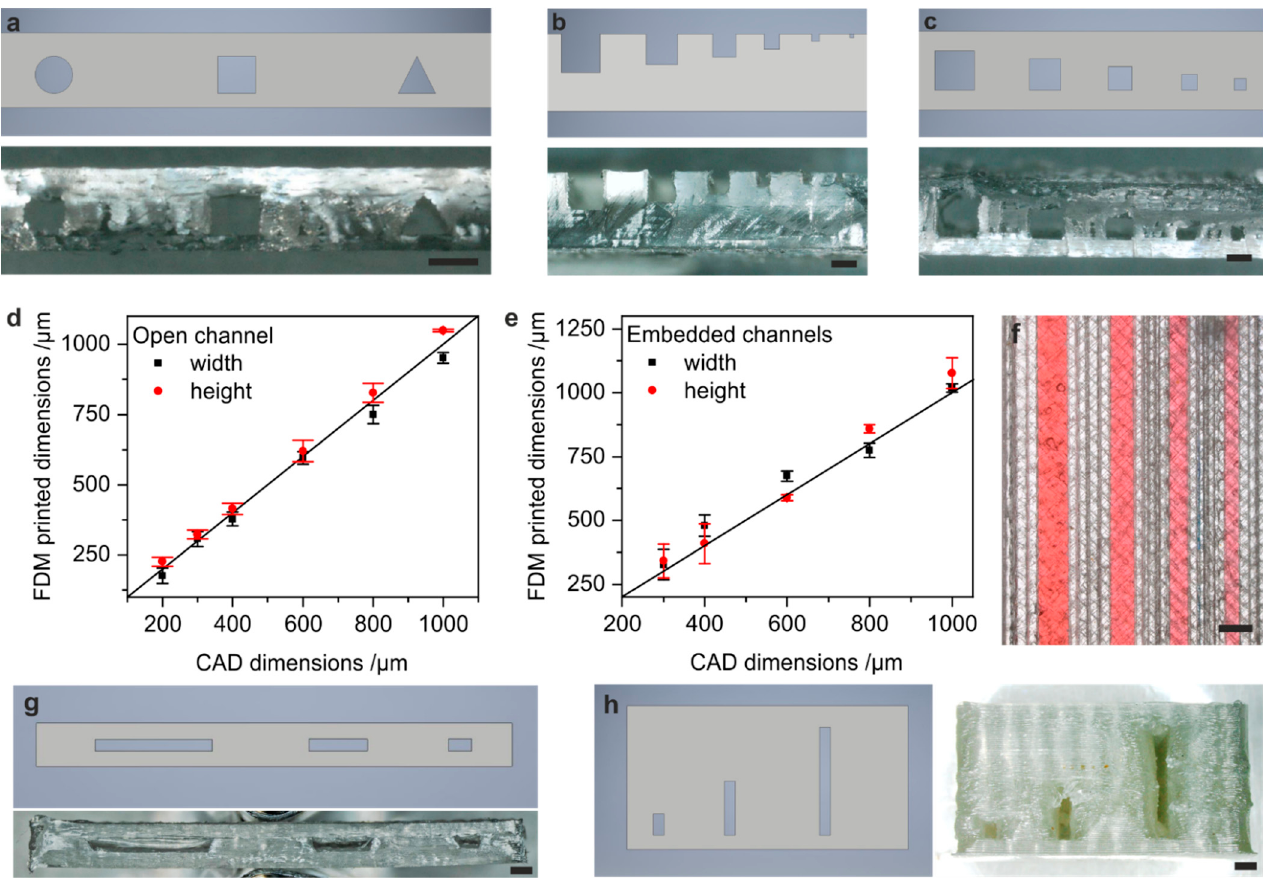
Figure 2. Accuracy and resolution of FDM-printed microfluidic channels in PS. ( a ) Cross-section of CAD model and FDM-printed PS, respectively, showing the possibility to print spherical, square and triangular channel cross-section with 600 µm features in high quality (scale bar 600 µm). ( b ) Cross section of CAD model and FDM-printed PS, respectively, showing open test channels with channel widths and heights of 1000, 800, 600, 400, 300 and 200 µm (scale bar 600 µm). ( c ) Cross section of CAD model and FDM-printed PS, respectively, showing embedded square test channels with channel widths and heights of 1000, 800, 600, 400 and 300 µm (scale bar 600 µm). ( d ) Comparison of the actual widths of FDM-printed open and embedded channels, shown in ( b , c ), over the original CAD dimension. ( e ) Comparison of the actual widths and heights of FDM-printed embedded microchannels shown in ( c ) over the original CAD dimensions. ( f ) The embedded microchannels shown in ( c ) were filled with dyed water to show full functionality (scale bar 1 mm). ( g ) Cross section of CAD model and FDM-printed PS, respectively, showing embedded test channels with lower aspect ratios of 0.5, 0.2 and 0.1 (scale bar 1 mm). The channel height was kept constant at 600 µm and the channel width was 1.2, 3 and 6 mm. ( h ) Cross section of CAD model and FDM-printed PS, respectively, showing embedded test channels with higher aspect ratios of 2, 5 and 10 (scale bar 1 mm). The channel width was kept constant at 600 µm and channel height was 1.2, 3 and 6 mm.